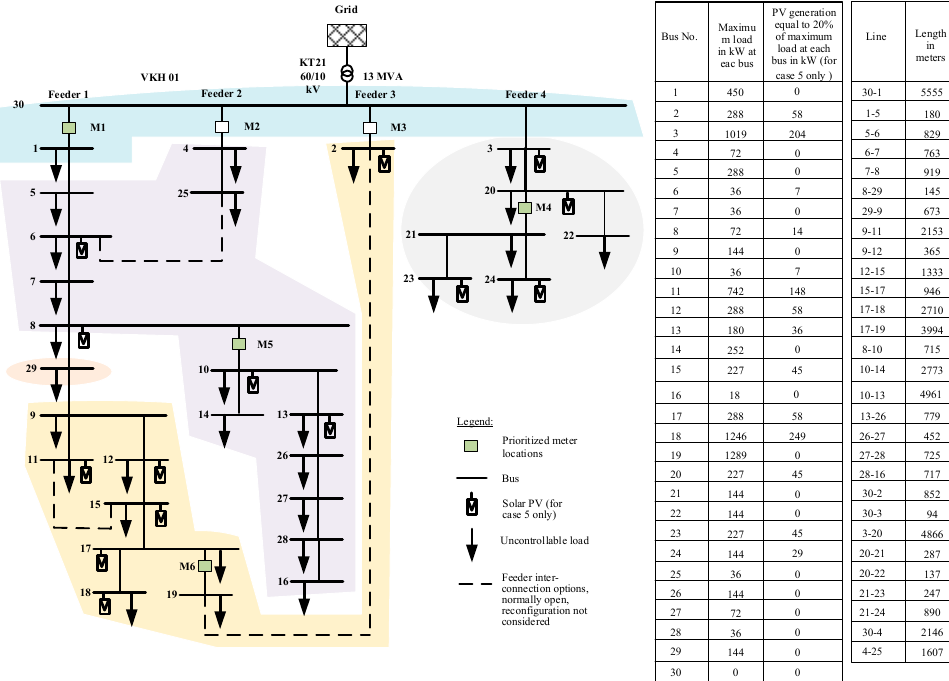
Figure 3. Modified MV network of Lind area, Denmark (observable islands in case 3).